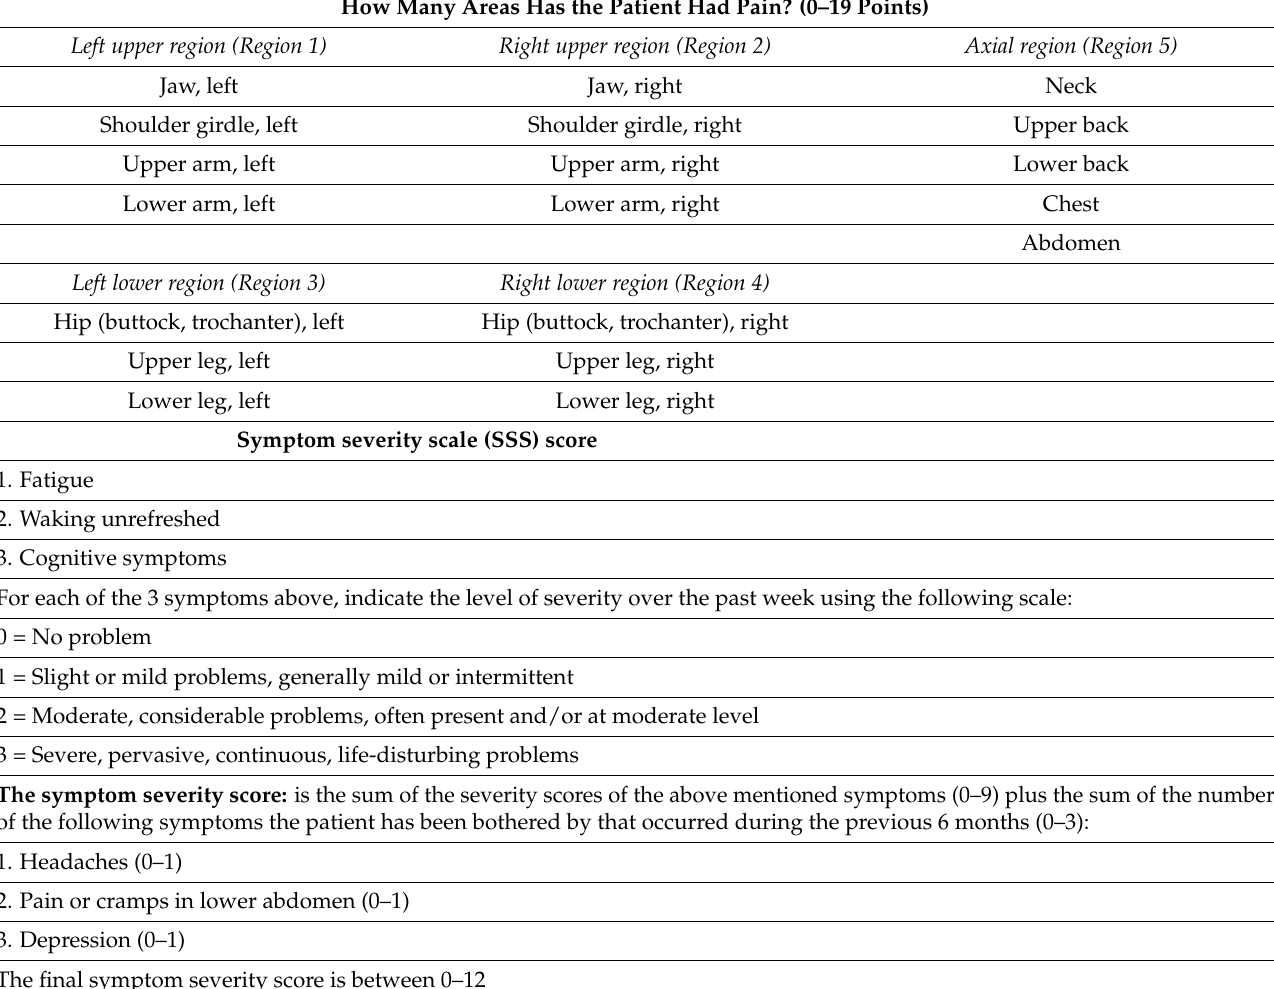
Table 4. Widespread pain index and Symptom severity scale scoring breakdown. Together they make up the fibromyalgia symptoms scale